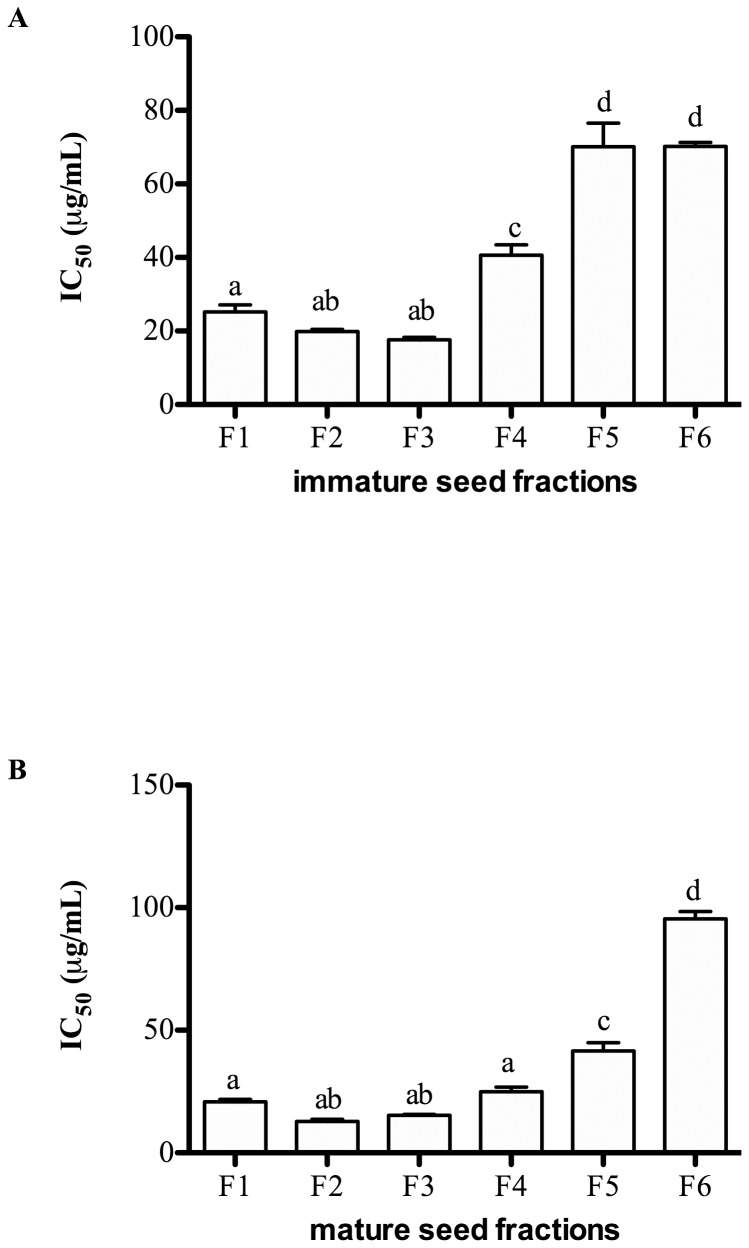
Viability of Caco-2 cells after exposure to fractions from immature (A) and mature (B) seed extracts for 72 hr measured by 3-(4,5-Dimethylthiazol-2yl)-2,5-diphenyl-tetrazolium bromide (MTT) assay.Data are expressed as IC50 or dose (µg/mL) inhibiting cell viability to 50% (mean ± SEM) of 3 independent experiments. Statistical analysis was determined by one-way ANOVA with Tukey'spost-hoc test. Values with different letters (a,b,c) in each column were statistically different at P<0.05.